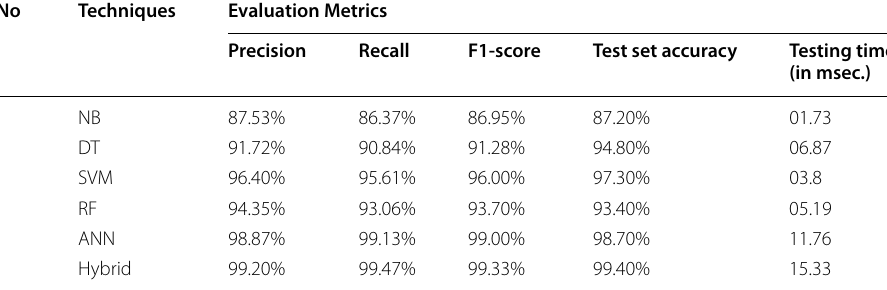
Table 9 Performance evaluation for test set No